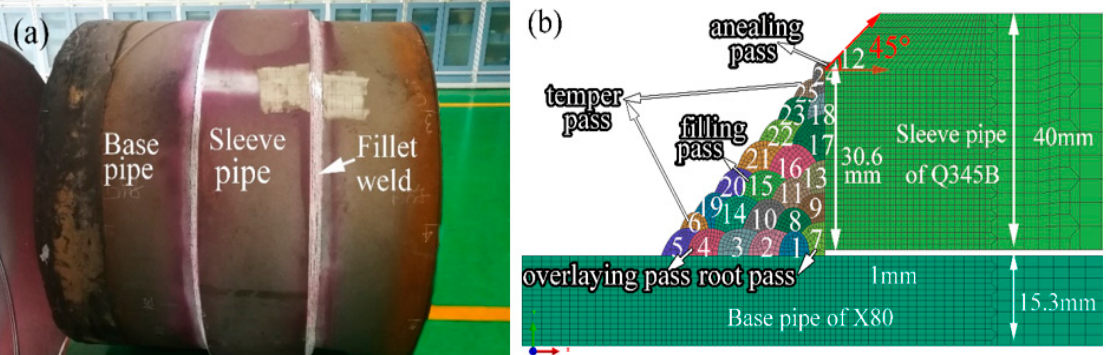
Figure 1. Schematic representation of type-B sleeve repair welding: ( a ) mock-up, ( b ) fillet weld. Table 1. Chemical compositions (in wt%) of X80, Q345B and E5515-G deposited metal.